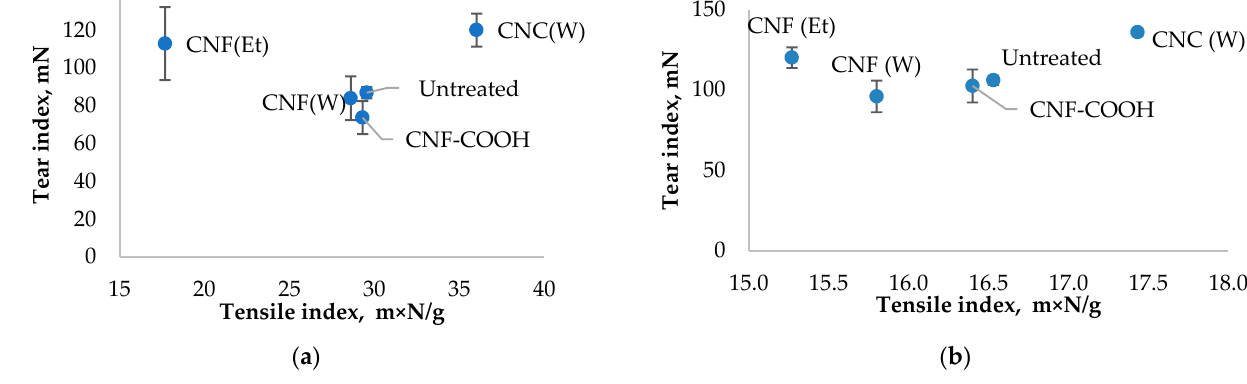
Figure 9. Tear and tensile indices for WBP reinforced with NC: ( a ) MD; ( b ) CD.